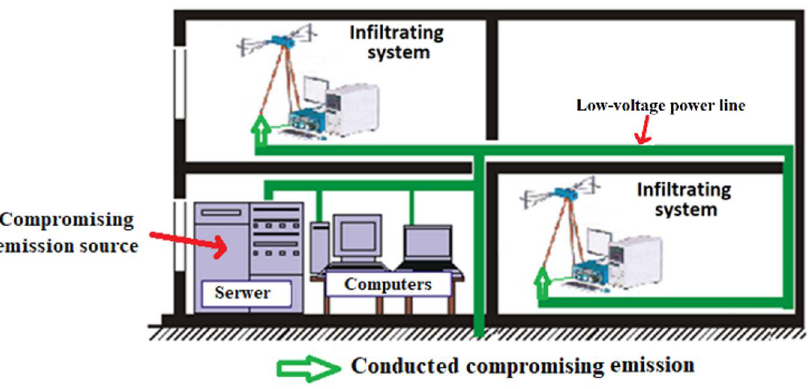
Figure 1. Propagation path diagram of conducted disturbances within the low voltage power lines in relation to the location of a potential infiltrating